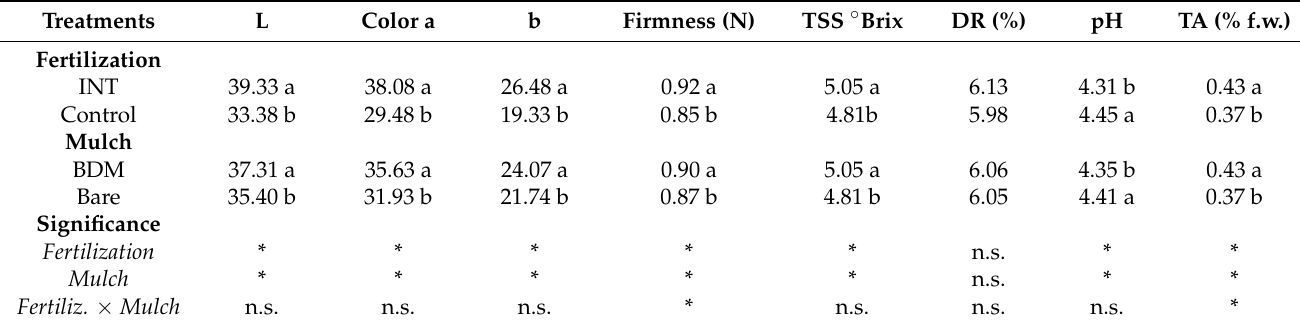
Table 6. Peel color, firmness, total soluble solids, dry residue, pH, and titratable acidity of tomato fruits of cv Heinz 5508, as influenced by the effects of fertilization and mulch in